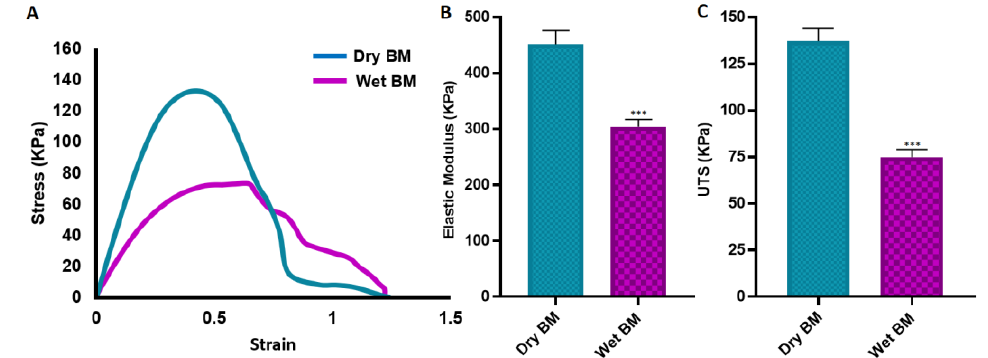
Figure 8. Mechanical properties of the BM under dry and wet conditions. ( A ) Representative stress-strain curves, ( B ) elastic modulus, ( C ) ultimate tensile strength (UTS) of the BMs under dry and wet conditions (*** p ≤ 0.001, n = 3).